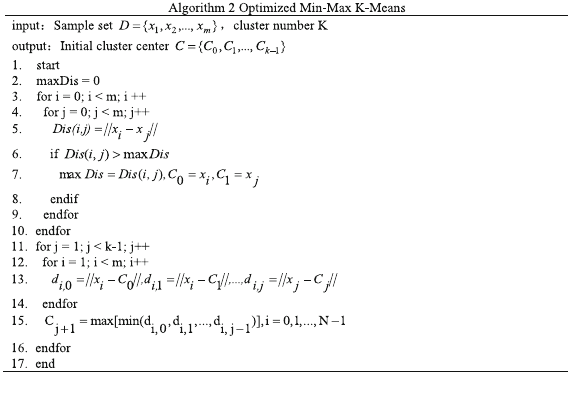
4 Adaptive differential evolution